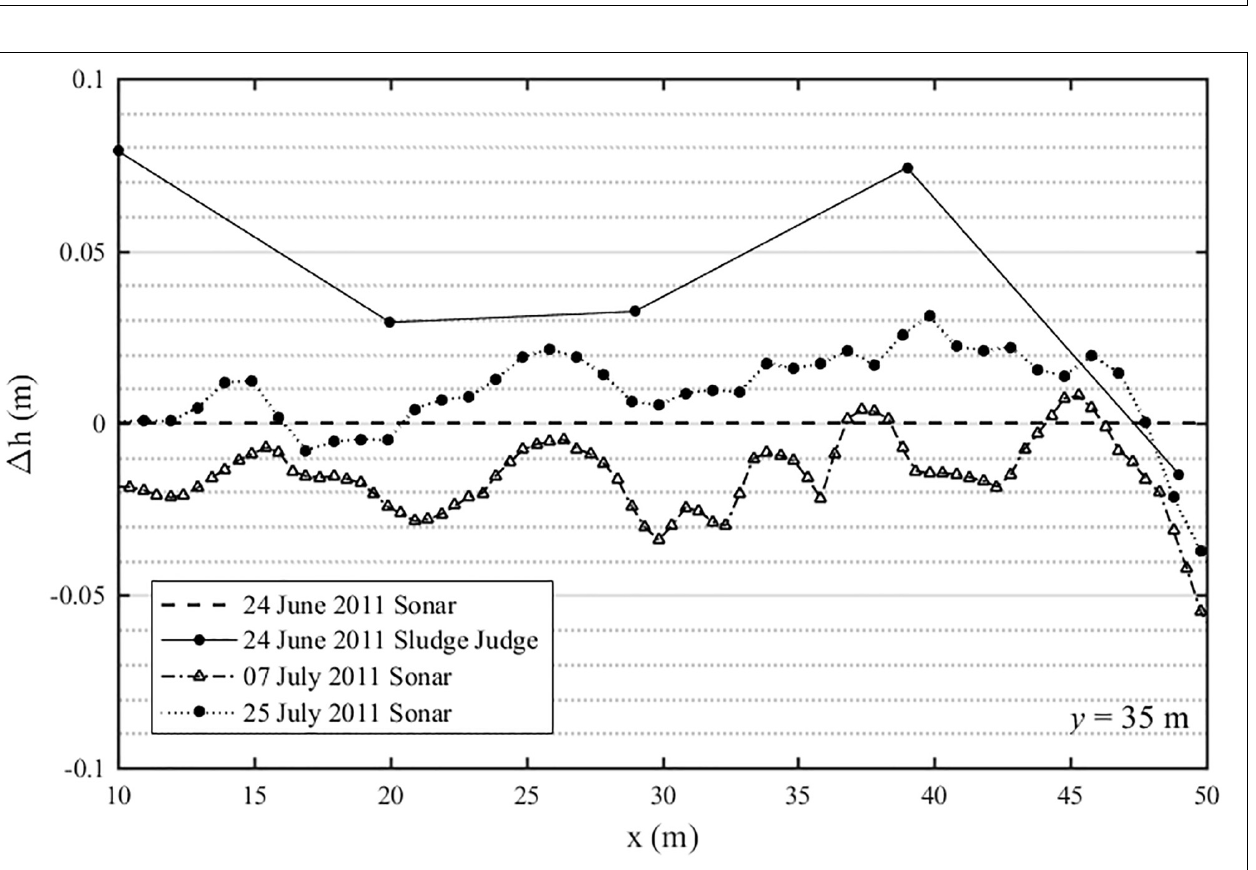
FIGURE 5 | A comparison of sludge height data collected at Pond 1 along transect y = 35 m, on three different profiling days using both the sonar and sludge judge techniques, normalized and shown as a change in height ( (cid:49) h) against the survey data collected on 24 June 2011 ( (cid:49) h = 0). From this comparison, we can see that the sonar profiling technique is very comparable between surveys, with the departure only being 2–3 cm. In comparison to the sludge judge survey conducted on the same day, it can be seen that the sludge judge technique overestimated the amount of sludge in the pond. It should be noted here that these departures could be due to GPS positioning differences, however, overall, we can see that the sonar technique is consistent in measurement.